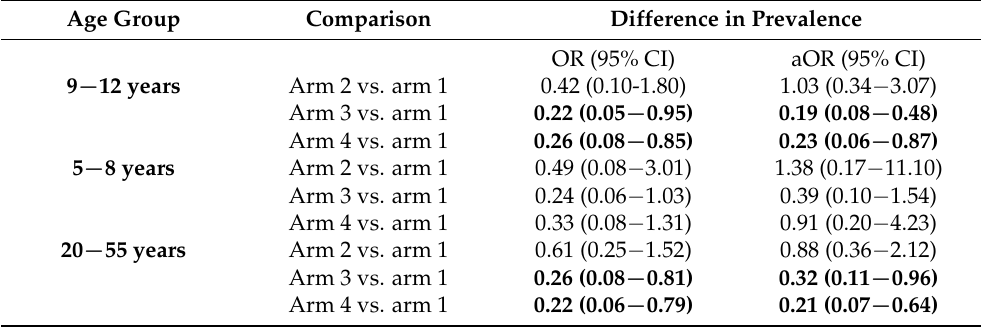
Table 3. GEE logistic model to assess OR and aOR between arms at the one-year follow-up for all age groups. aOR, adjusted odds ratio; CI, confidence interval; OR, odds ratio. The adjusted model includes age, sex, and cluster level baseline prevalence as additional covariates and is weighted to account for different numbers of observations in each